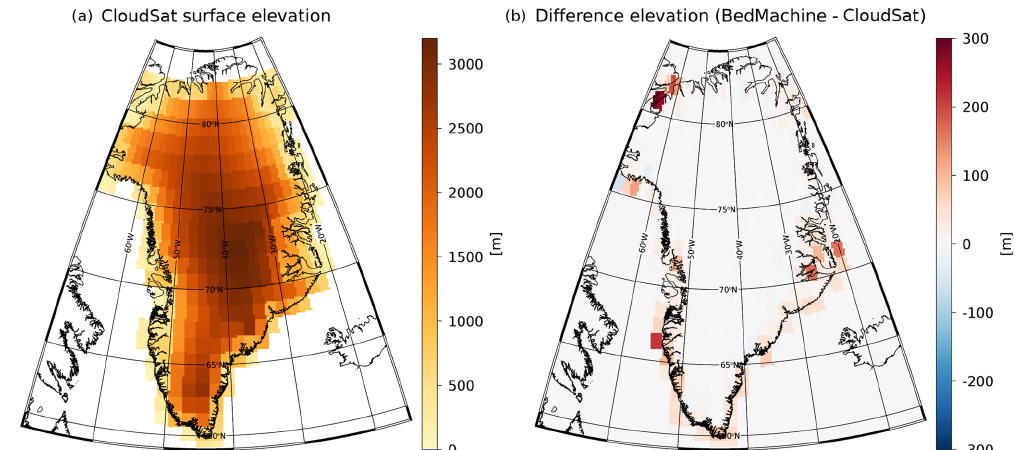
Figure 3. Panel (a) shows the mean elevation reported from CloudSat binned to 1 ◦ × 2 ◦ . Panel (b) shows the difference between the elevation difference between IceBridge BedMachine v3 (Morlighem et al., 2017) and CloudSat. Note that open water and sea ice observations are excluded from the dataset, so that differences observed near the coast only stem from ice-free land or GrIS observations within each grid box.